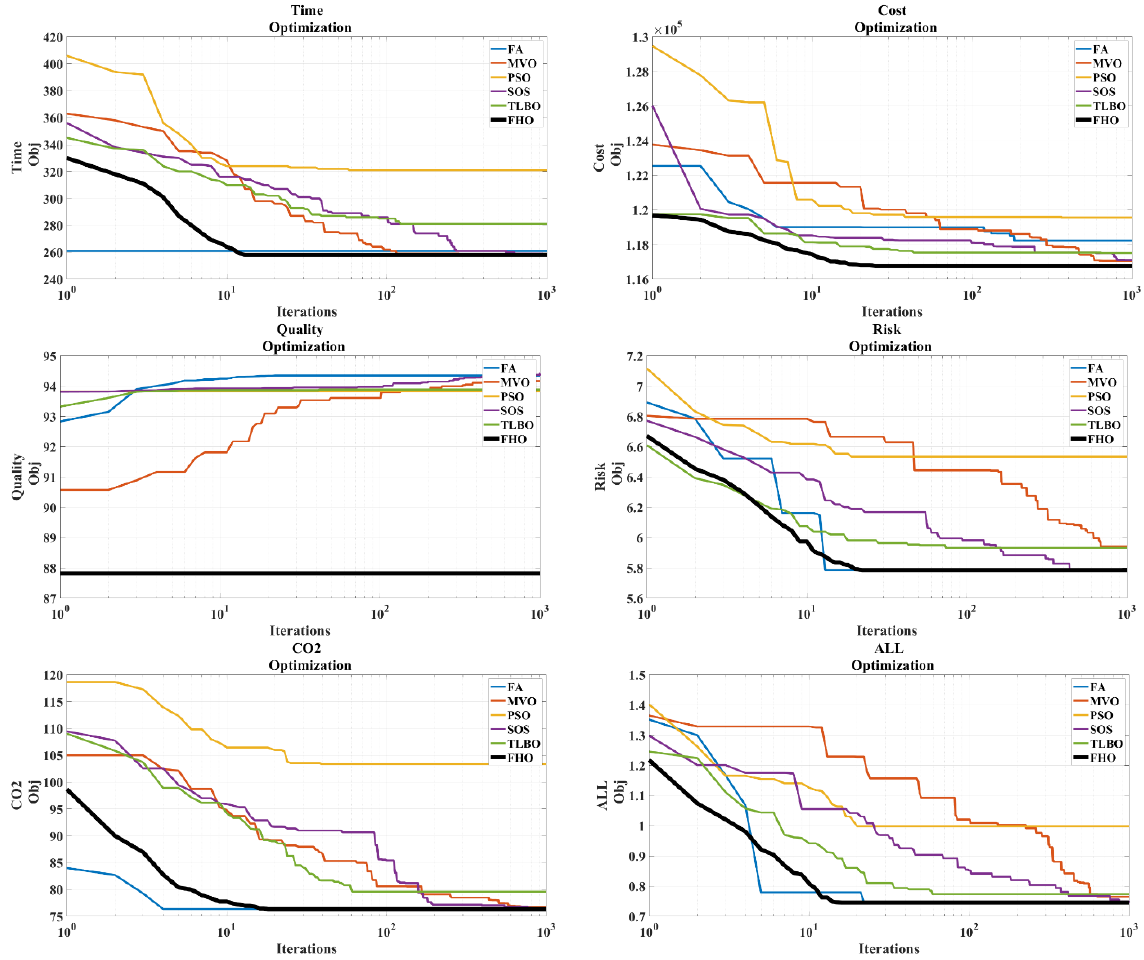
Figure 4. Convergence history of 30 independent optimization runs of FHO and alternative algo- rithms.